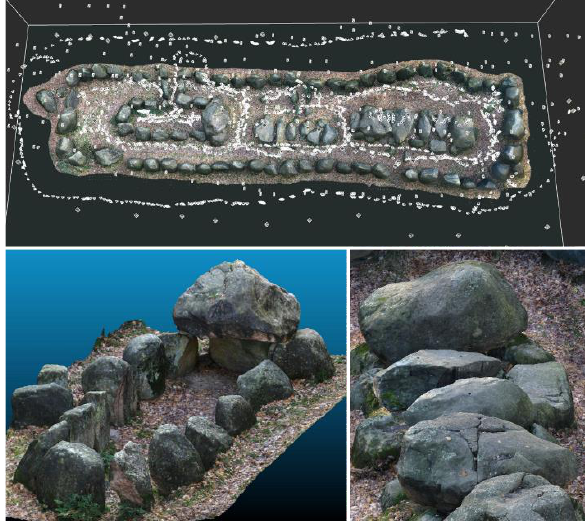
Figure 6: TLS, terrestrial images and UAV orientations (top), detailed view of the calculated mesh